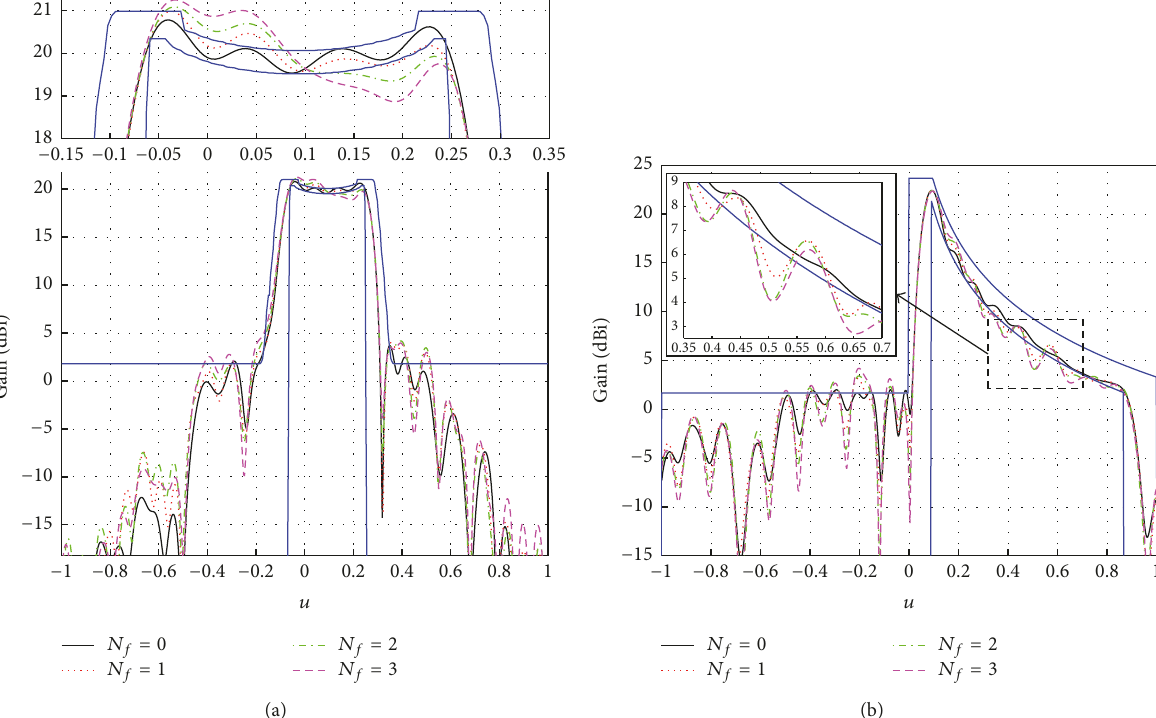
Figure 6: Dielectric frame effect on the shaped patterns for 𝑋 polarization when it is added after a synthesis was carried out. 𝑁 𝑓 indicates the number of extra elements added as dielectric frame at each edge of the reflectarray. (a) Asymmetric cut of isoflux pattern. (b) Elevation cut of LMDS